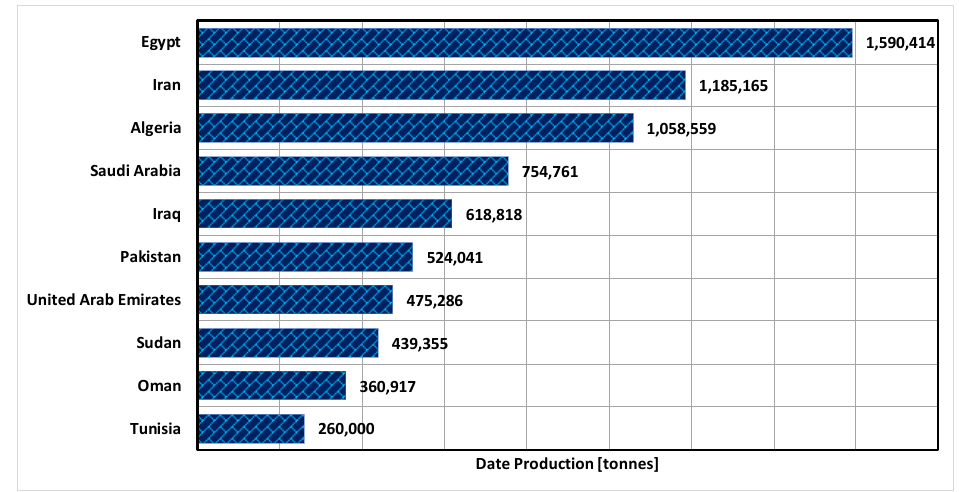
Figure 1. Top ten global date fruit producers in 2017 [17].